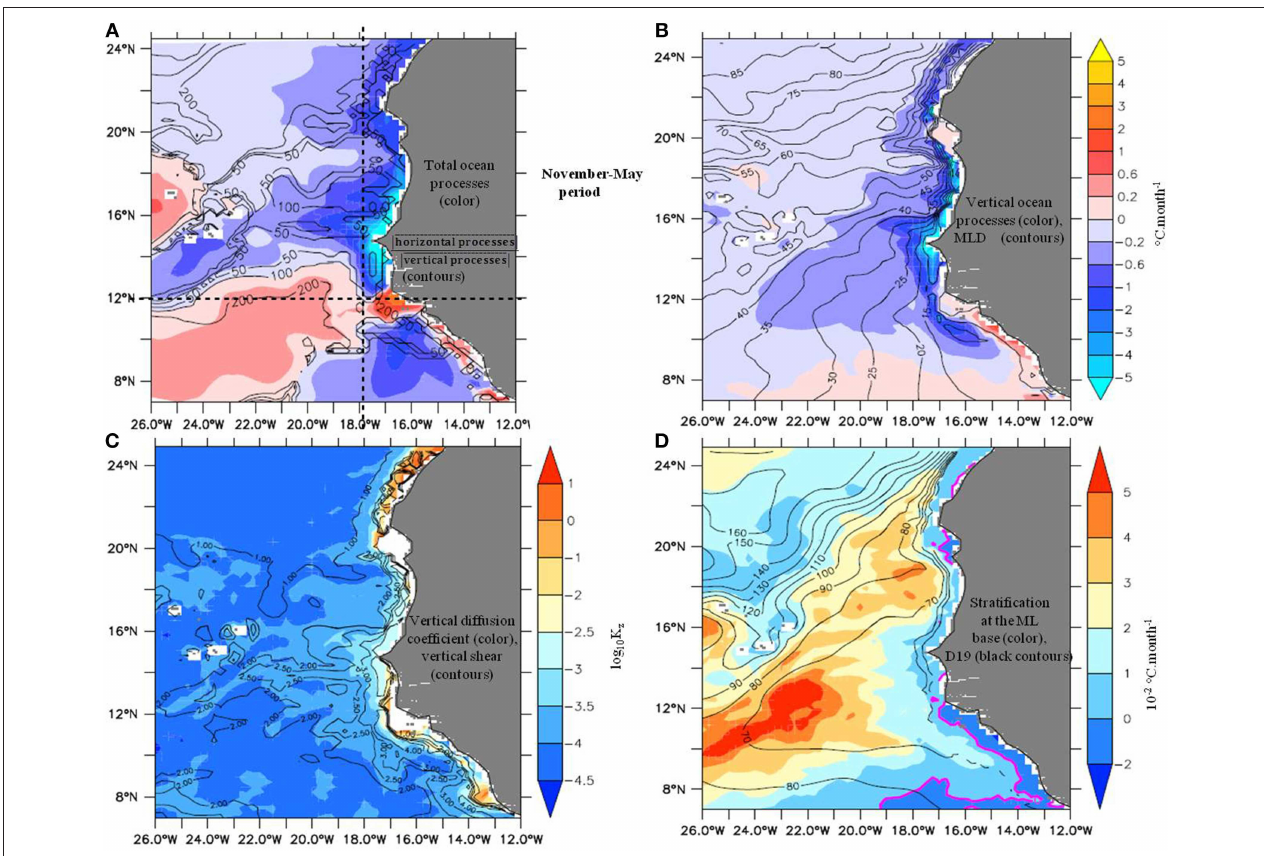
FIGURE 7 | Model oceanic trends averaged over CP averaged over the CP period. (A) Total ocean effect (shading, ◦ C.month − 1 ) and ratio of contributions of horizontal processes over vertical processes, each in time-average (black contours), (B) Vertical processes effect (shading, ◦ C.month − 1 ) and mixed layer depth (MLD, black contours, m), (C) vertical diffusion coefficient (shading, m 2 .s − 1 ) and square of the vertical shear at the base of the ML (black contour, s − 2 ), and (D) vertical temperature gradient at the base of the ML (shading, ◦ C.m − 1 ) and the 19 ◦ C isotherm depth (black contours,